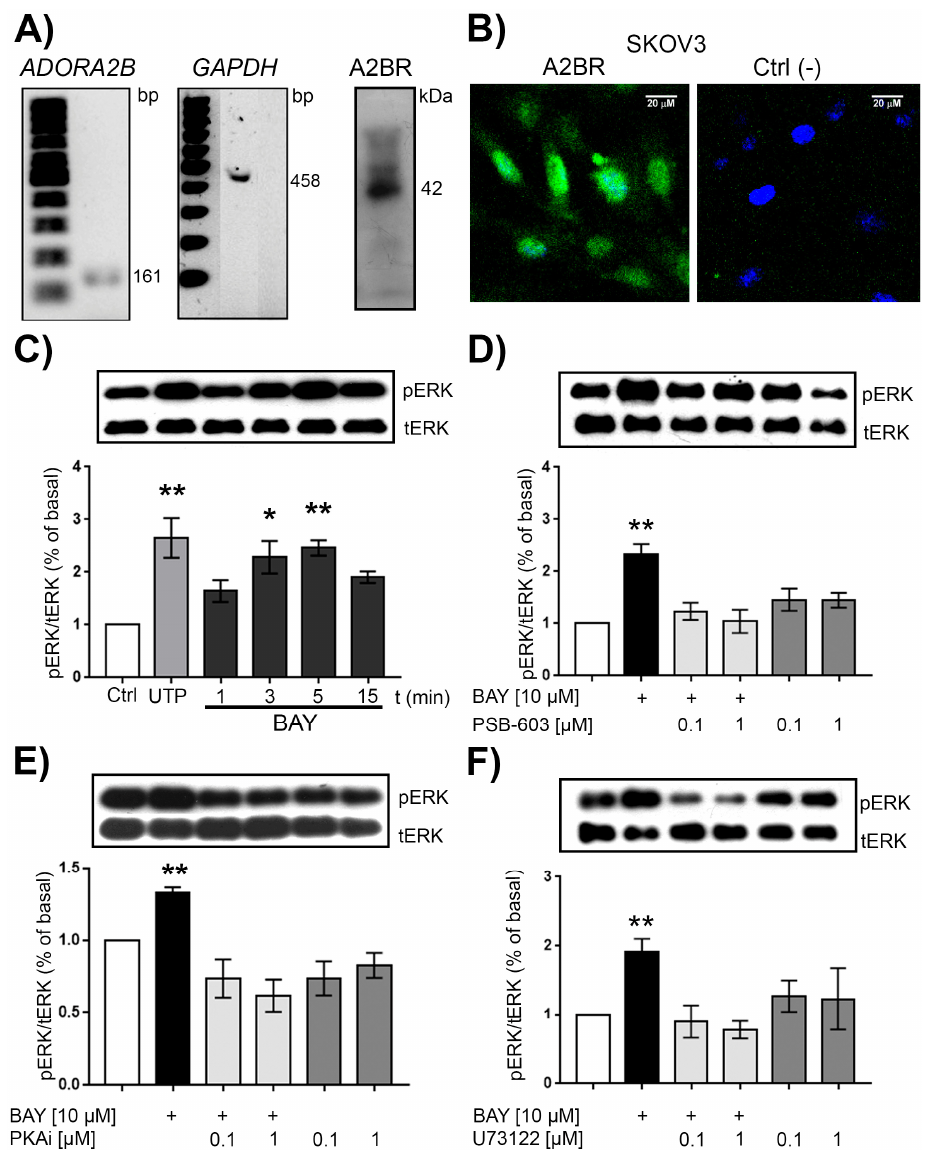
Figure 2. Ovarian carcinoma-derived SKOV-3 cells express functional A2BR. ( A ) A fragment of the ADORA2B transcript was amplified by RT and PCR using specific oligonucleotides. An am- plicon of 161 bp was obtained. GAPDH was used as a constitutive transcript ( left panels ). A2BR was detected by Western blot and immunoprecipitation of biotinylated membrane proteins from SKOV-3 cells; a main band of around 42 kDa was detected ( right panel ). ( B ) A2BR was labeled by immunofluorescence. The immunoreactivity was detected with a secondary antibody conjugated with AlexaFluor 488 (green signal). Nuclei were counterstained with DAPI (blue signal). ( C ) Cell cultures were stimulated with 10 µ M of BAY-606583 for 1, 3, 5 or 15 min. Phosphorylated ERK (p-ERK) and total ERK (t-ERK) were detected by Western blot in the same membrane. As a positive control, UTP 100 µ M was utilized. ( D ) ERK phosphorylation induced after 5 min of stimulation with BAY-606583 was prevented by the A2BR antagonist PSB-603; this effect was also inhibited by a PKA inhibitor ( E ) or by U73122, a PLC inhibitor ( F ). In the graphs, bars represent the mean ± S.E.M. of four independent experiments in duplicate. * p < 0.05, ** p <